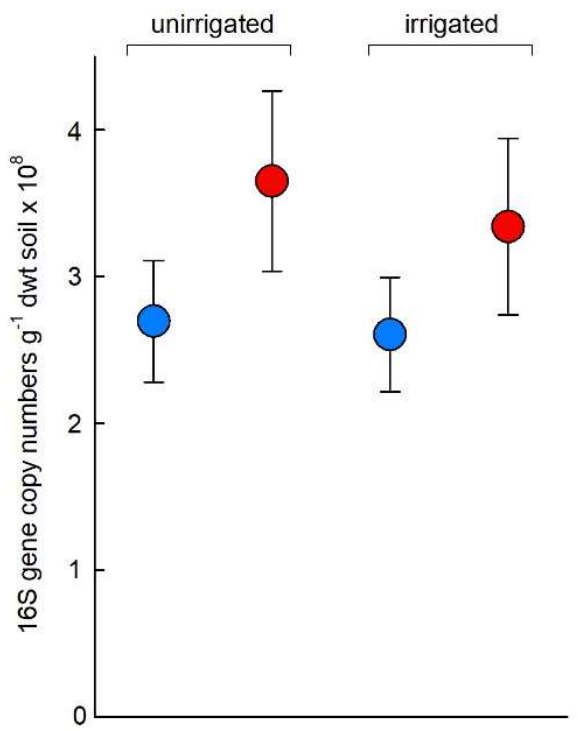
Figure 4. Copy numbers of bacterial 16S ribosomal RNA genes in soil. Values are means of 11–12 replicates ± SEM. See key in Figure 2a for treatment notation.